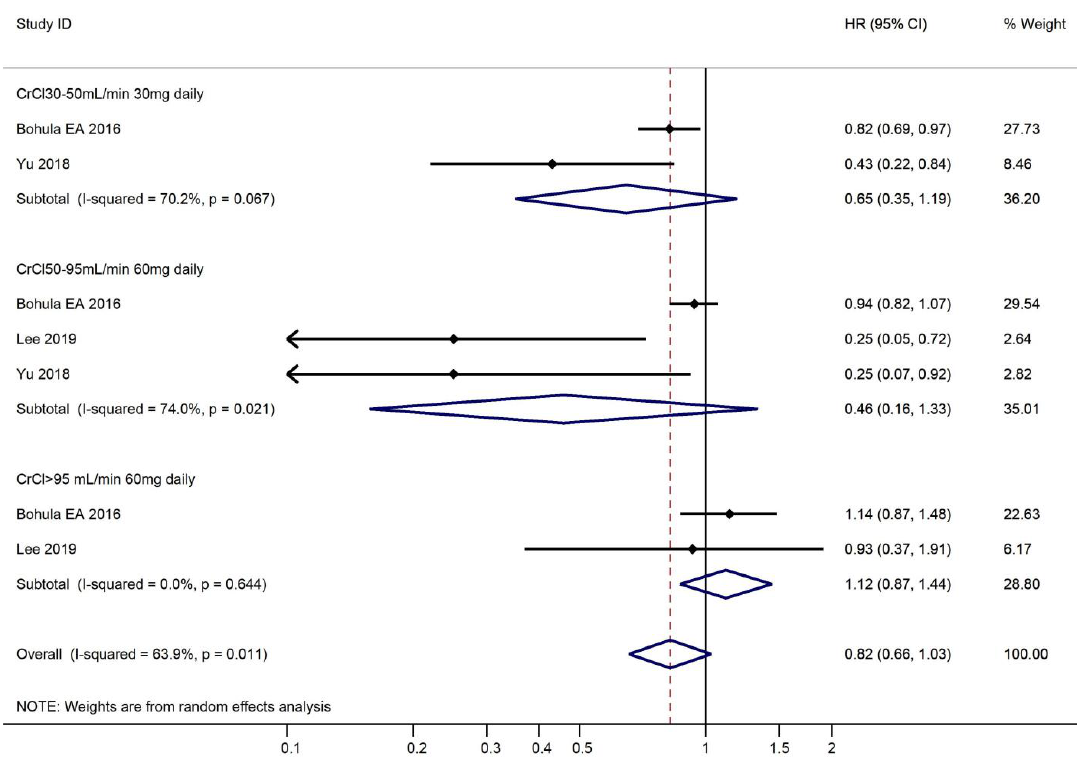
Figure 7. Risk of mortality and use of edoxaban versus warfarin in relation to CrCl.